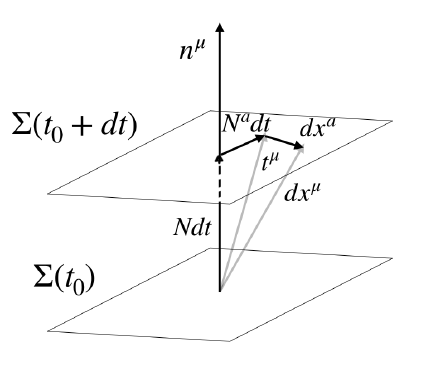
Figure 1. Splitting the spacetime into space and